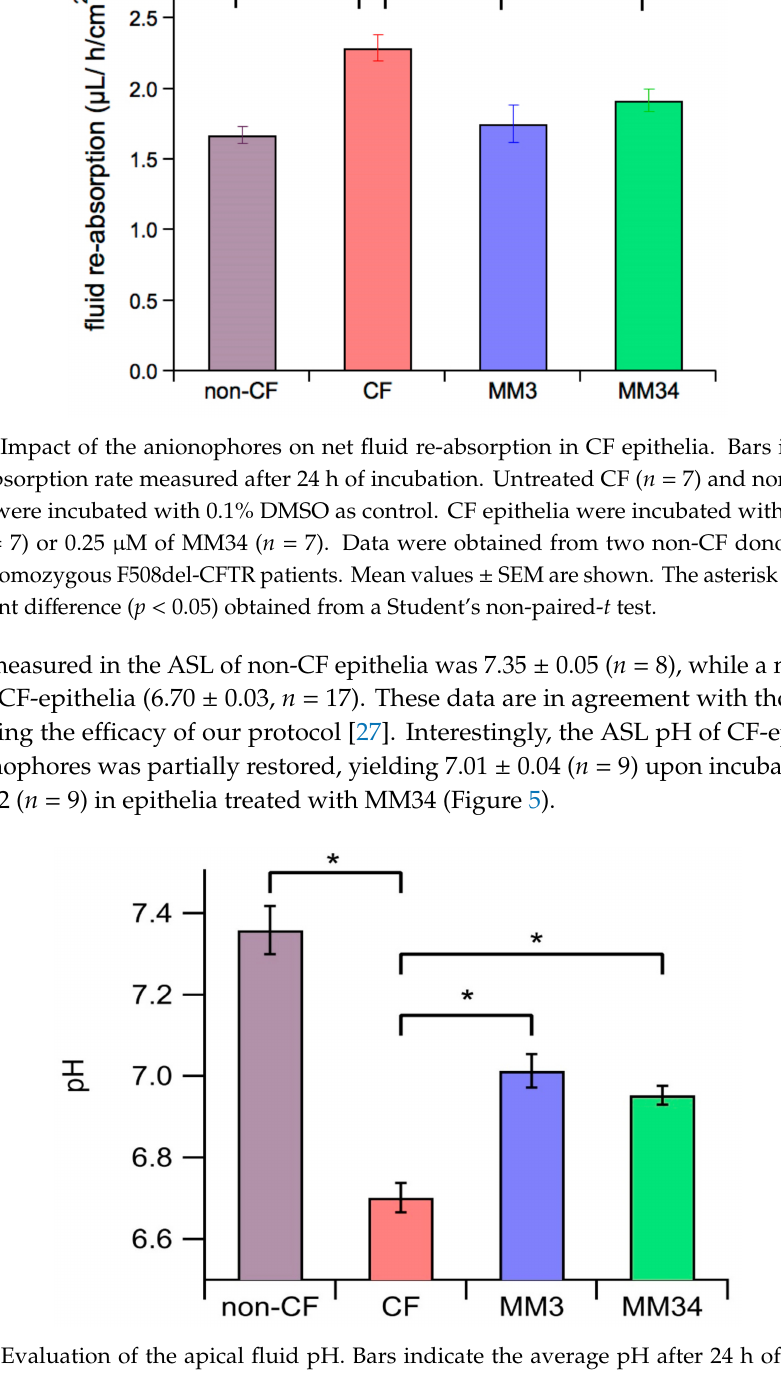
Figure 5. Evaluation of the apical fluid pH. Bars indicate the average pH after 24 h of incubation. Untreated CF ( n = 17) and non-CF ( n = 8) epithelia were incubated with 0.1% DMSO as control. CF epithelia were incubated with 0.25 µ M of MM3 ( n = 9) or 0.25 µ M of MM34 ( n = 9). Data were obtained from two non-CF donors and two di ff erent homozygous F508del-CFTR patients. The asterisk (*) indicates a significant di ff erence ( p < 0.05) obtained from a Student’s non-paired- t